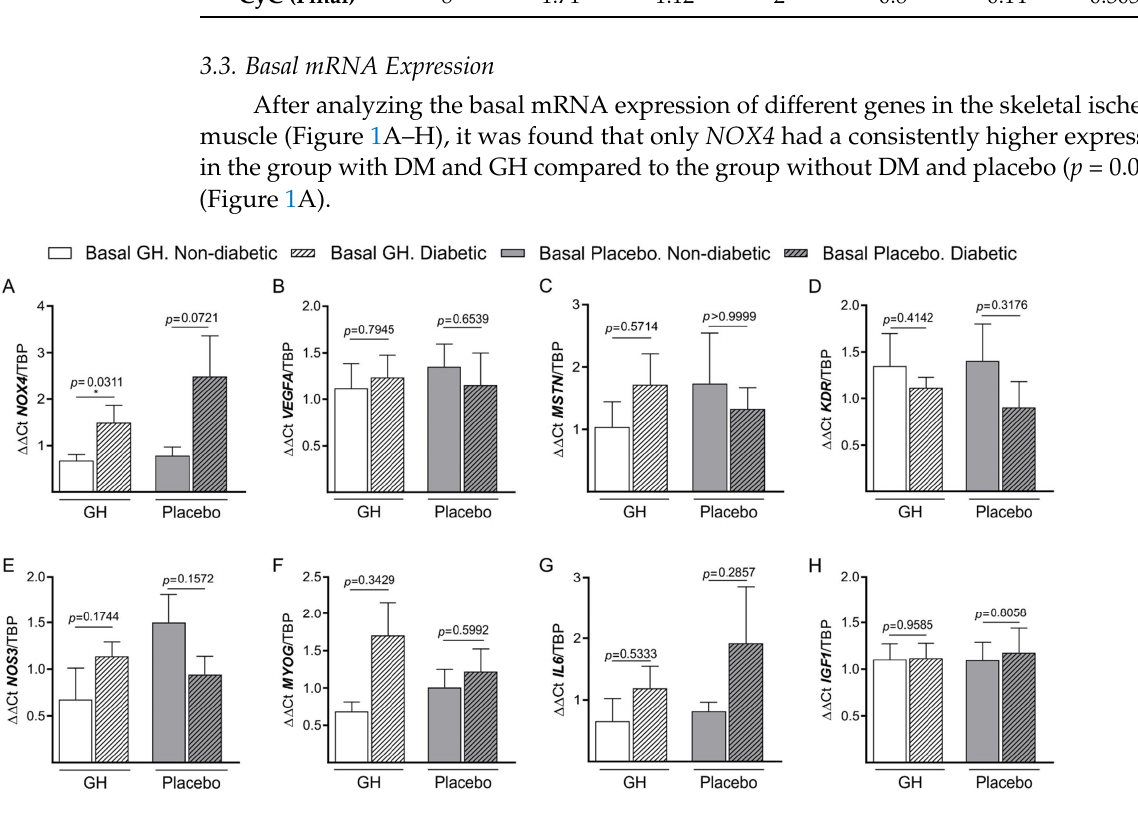
Figure 1. mRNA expression of different genes at baseline in both groups, GH, and placebo) in DM and non-DM patients . ( A ). NOX4 : NADPH (Nicotinamide adenine dinucleotide phosphate oxidase) 4; ( B ). VEGFA : Vascular endothelial growth factor A; ( C ). MSTN : Myostatin; ( D ). KDR : VEGFA receptor 1. ( E ). NOS3 or eNOS : Nitric oxide synthase 3 or endothelial NOS; ( F ). MYOG : Myogenin; ( G ). IL6 : Interleukin 6; ( H ). IGF1 : Insulin-like growth factor I; GH: Growth hormone; Placebo: control group; Basal: Baseline. * p <